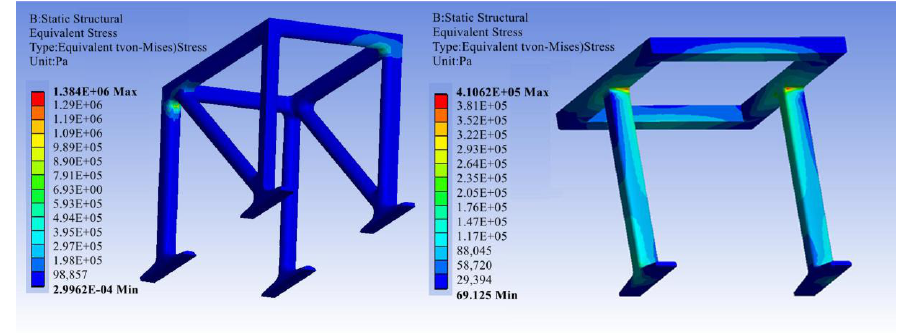
Figure 22. Stress analysis for comparison of the triangular hinge and simple straight hinge (equivalent Figure 22. stress).